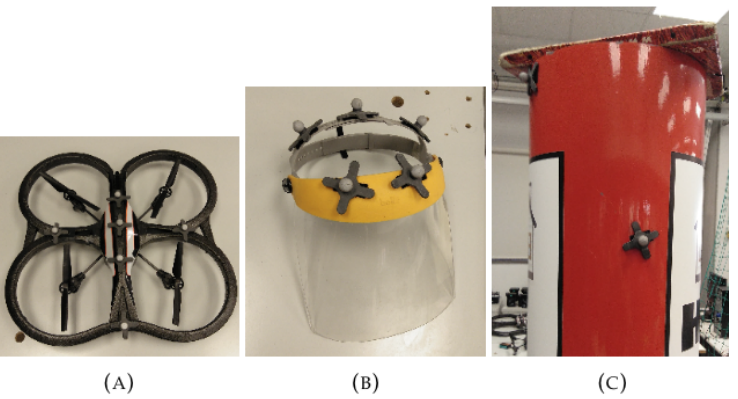
Figure 11. Hardware involved: SMarkers applied to ( A ) the AR.Drone, ( B ) the main human protective gear and ( C ) the